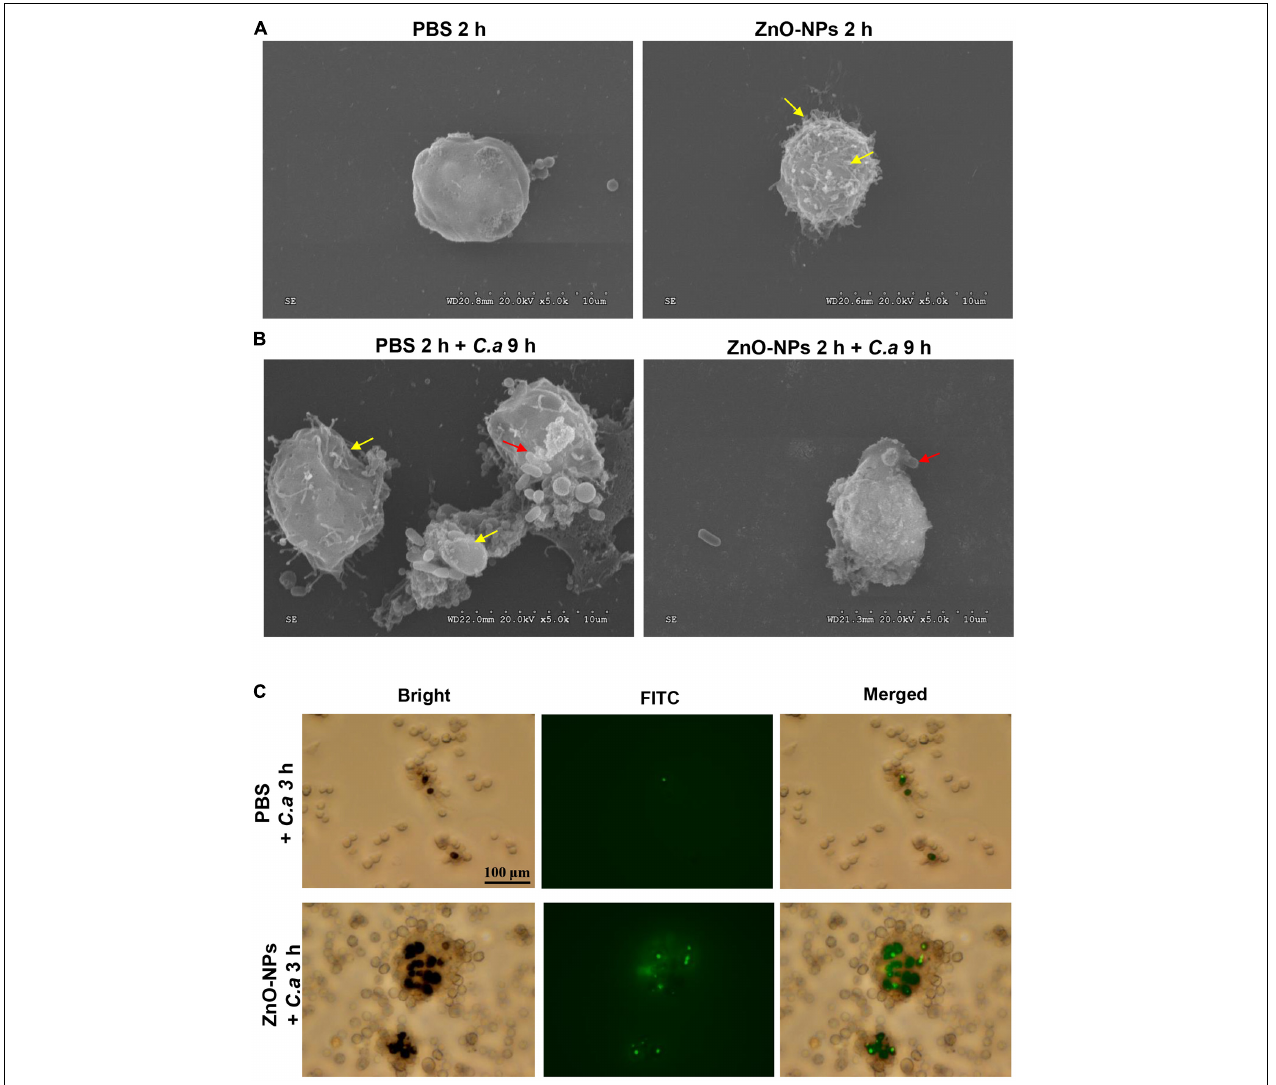
FIGURE 6 | Micromorphology change and phagocytosis of hemocytes in ZnO-NP-pretreated G. mellonella with/without C. albicans challenge. (A,B) Scanning electron microscopy (SEM) presenting micromorphology change of hemocytes collected from ZnO-NP-pretreated G. mellonella with/without C. albicans challenge. PBS pretreatment was applied as the control. (A) The yellow arrows indicate shrinking and burring protrusion on the surface of hemocytes exposed to ZnO-NPs without C. albicans infection. (B) Following the challenge with C. albicans for 9 h, hemocytes presented irregular and partly destroyed by C. albicans (yellow arrows) in PBS-pretreated larvae but hemocytes engulfed C. albicans (red arrow) significant morphological changes in ZnO-NP-pretreated larvae. Micromorphology change was shown at × 5,000 magnification. (C) Representative microphotographs showing phagocytosis of fluorescein isothiocyanate isomer (FITC)-labeled C. albicans by hemocytes in G. mellonella . Larvae were pretreated with ZnO-NPs or PBS and then challenged with FITC-labeled C. albicans for 3 h at 37 ◦ C. Hemolymph was obtained from each larva separately and 10-fold diluted in a 12-well plate for microscope observation. Scale bar, 100 µ